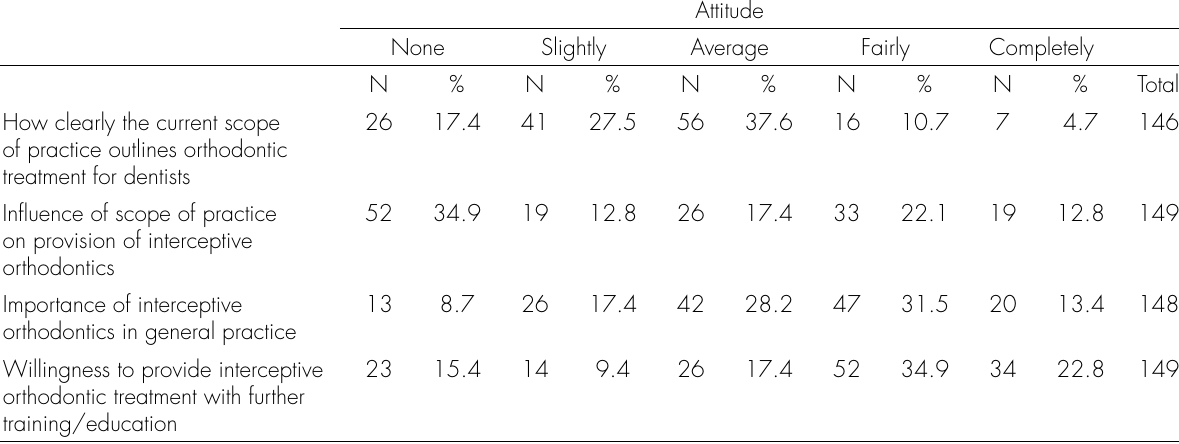
Table III. General dentists’ attitude towards interceptive